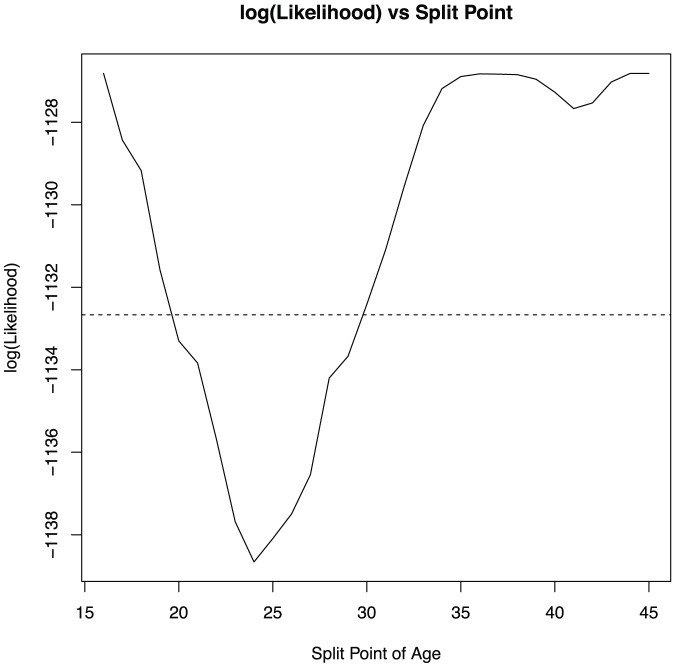
Split-point, K, against log likelihood. Values below the dotted line are part of the confidence region.